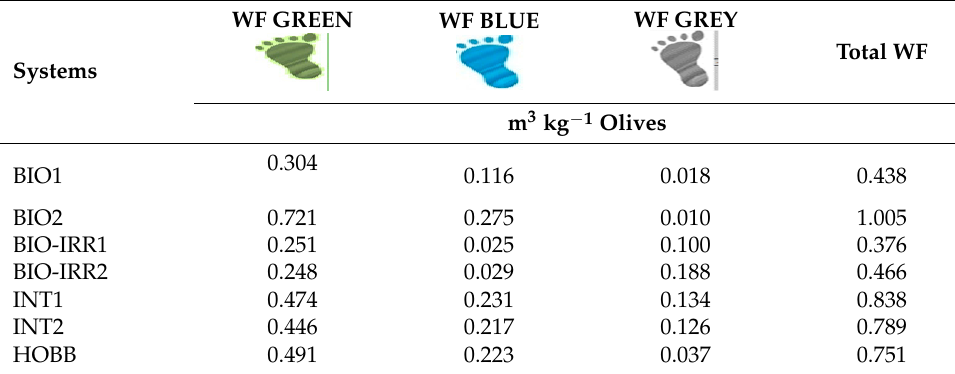
Table 8. Total WF broken down by its components (green, blue and grey) in the analyzed systems. Values are expressed in m 3 kg − 1 olives.